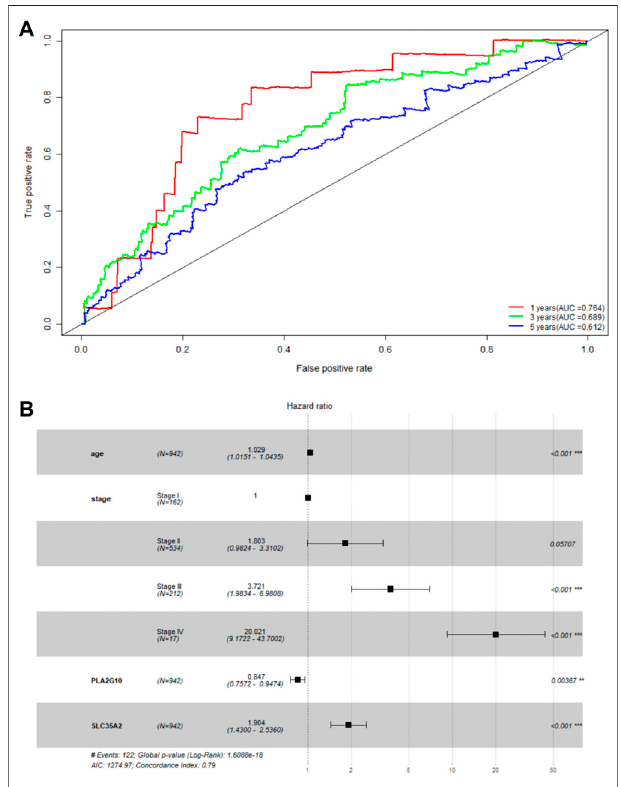
FIGURE 2 | Validation of MGS. (A) AUC of time-related ROC curves for MGS at 1, 3 and 5 years in the TCGA cohort. (B) Forest map analysis of SLC35A2 and PLA2G10 expression and clinicopathologic characteristics of BC patients by Multivariate Cox Proportional Hazards Regression analysis. * p < 0.05; ** p < 0.01; *** p <